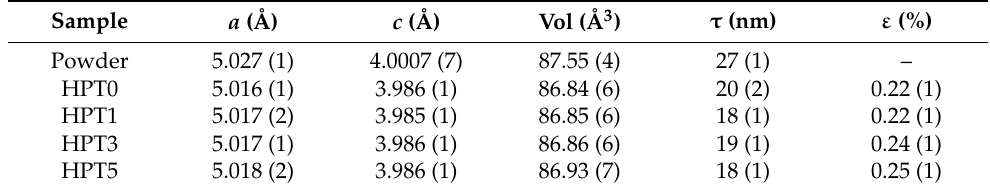
Table 2. Results of Rietveld refinements of the patterns displayed in Figure 5. a and c are the lattice parameters of LaNi 5 unit cell (space group P6/mmm). Vol is the unit cell volume τ is the crystallite size and ε is the microstrain. Error on the last significant digit is indicated in